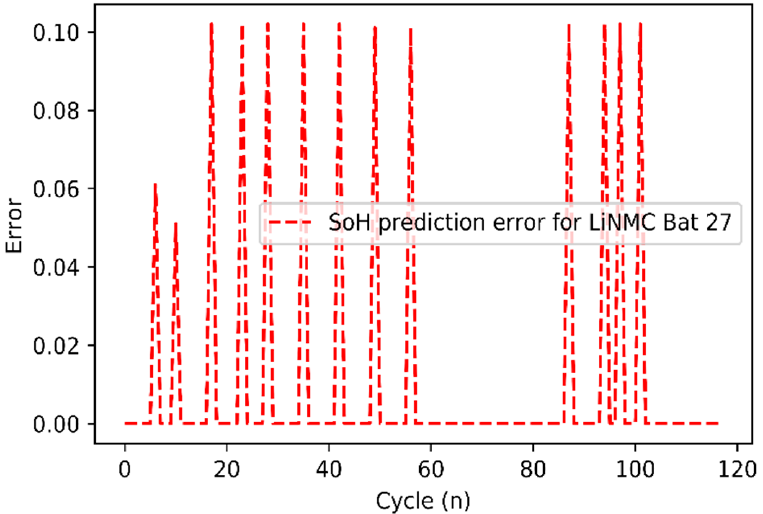
Figure 11. The error in predicting the SOH for battery 27.